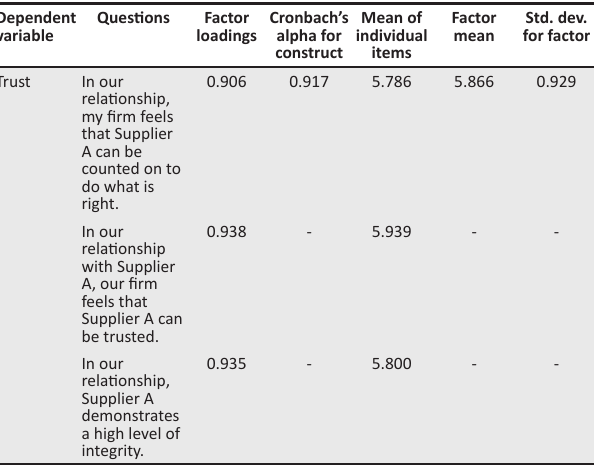
TABLE 3: Construct scales for trust. Dependent variable